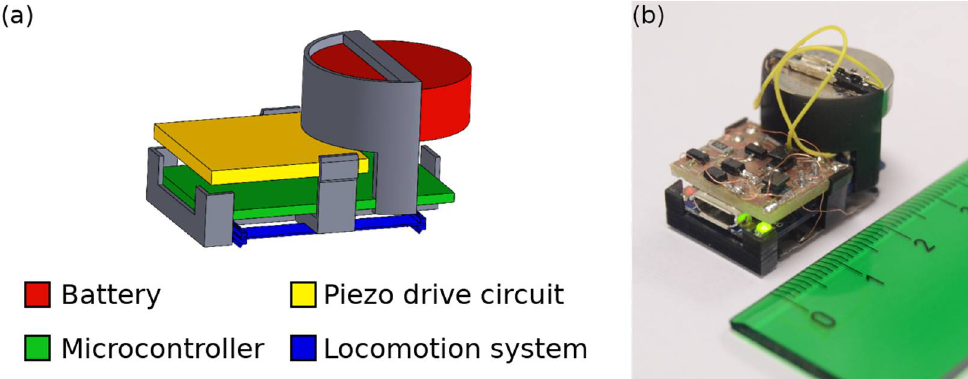
Figure 1. ( a ) Drawing with the parts of the robot. ( b ) Photograph of the fully-assembled robot. Ruler marked in cm.